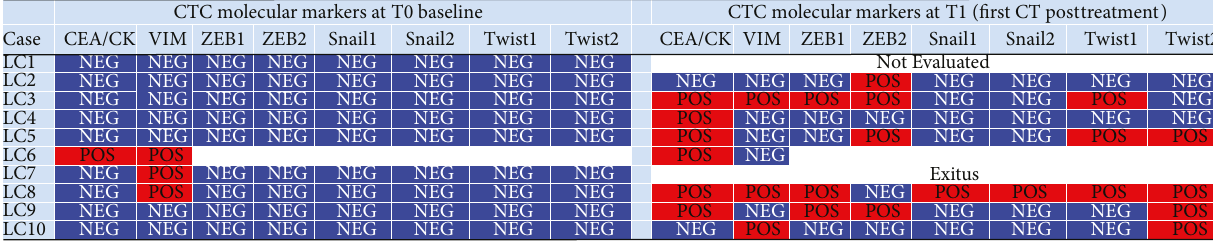
Figure 5: CTC-positive samples (red) with mRNA levels higher than the cuto ff of epithelial and/or at least an EMT-related gene.